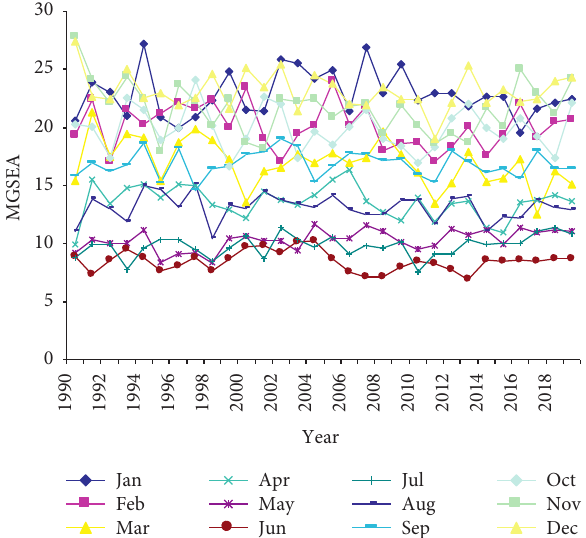
Figure 3: Monthly global solar energy average in Queensland,